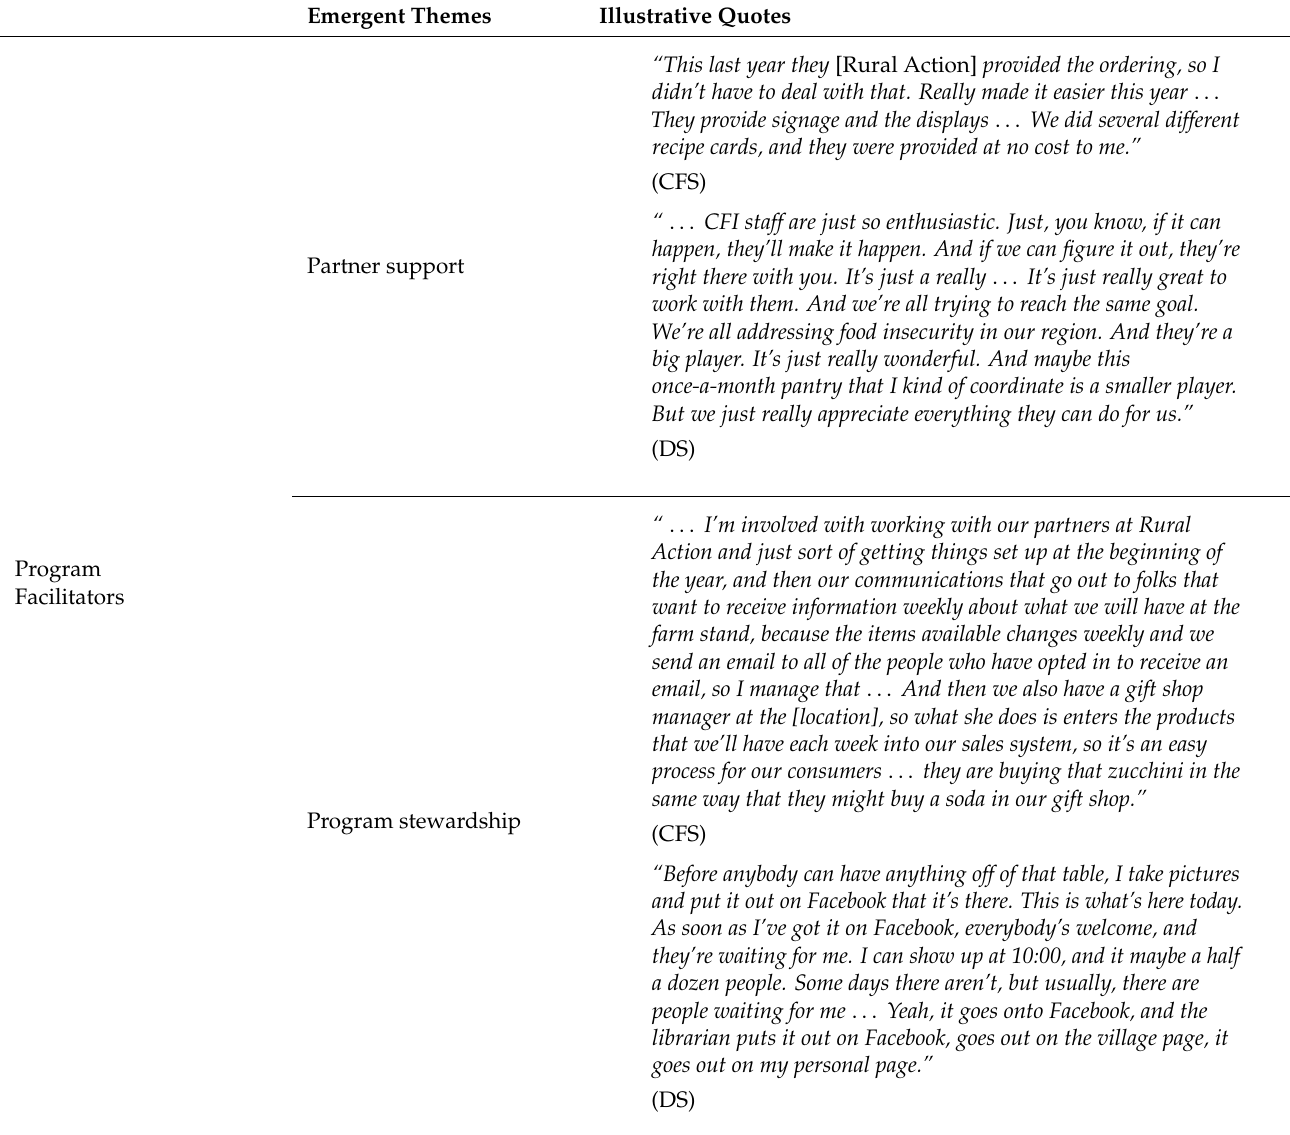
Table A3. Illustrative quotes from Country-Fresh-Stop- and Donation-Station-affiliated sites, organized by